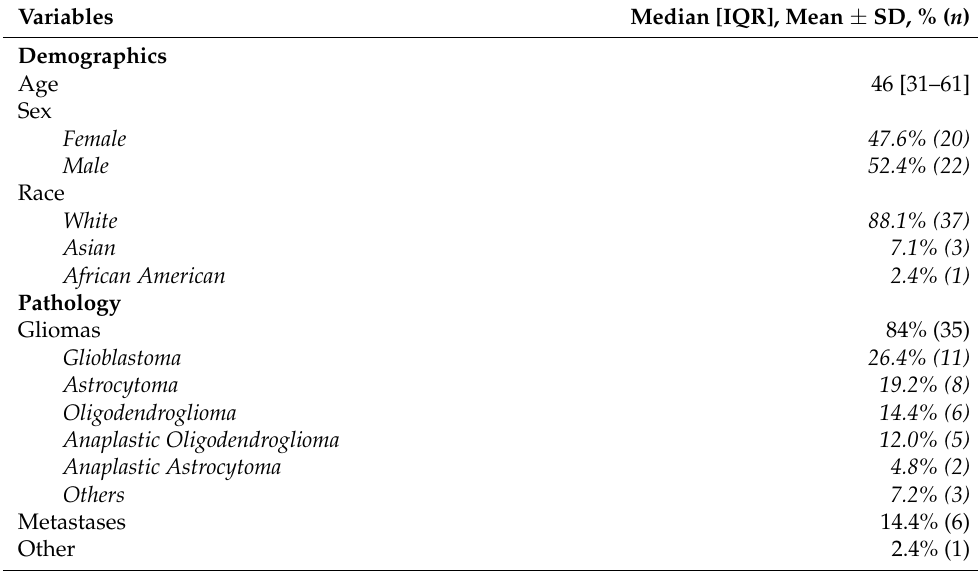
Table 1. Distribution of patient demographics and intracranial pathologies ( n = 42).